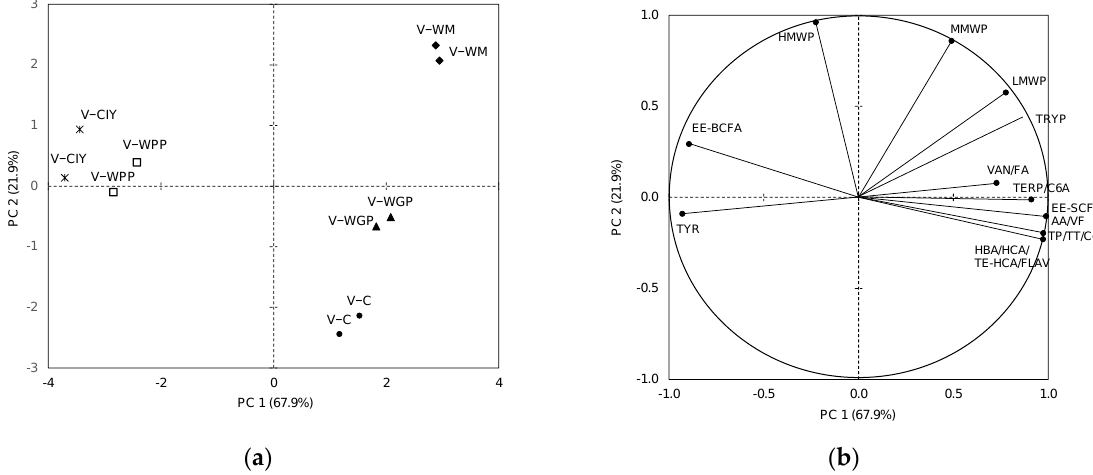
Figure 2. Principal component analysis: ( a ) distribution of the Verdejo wines; ( b ) loadings of the variables. C: control wines, WM: wines with the addition of PSs extracted from white must, WGP: wines with the addition of PSs extracted from white grape pomace, WPP: wines with the addition of wine purified polysaccharide rich in RG-II, CIY: wines with the addition of commercial inactivated yeasts. Abbreviations of compounds in Materials and Methods section.